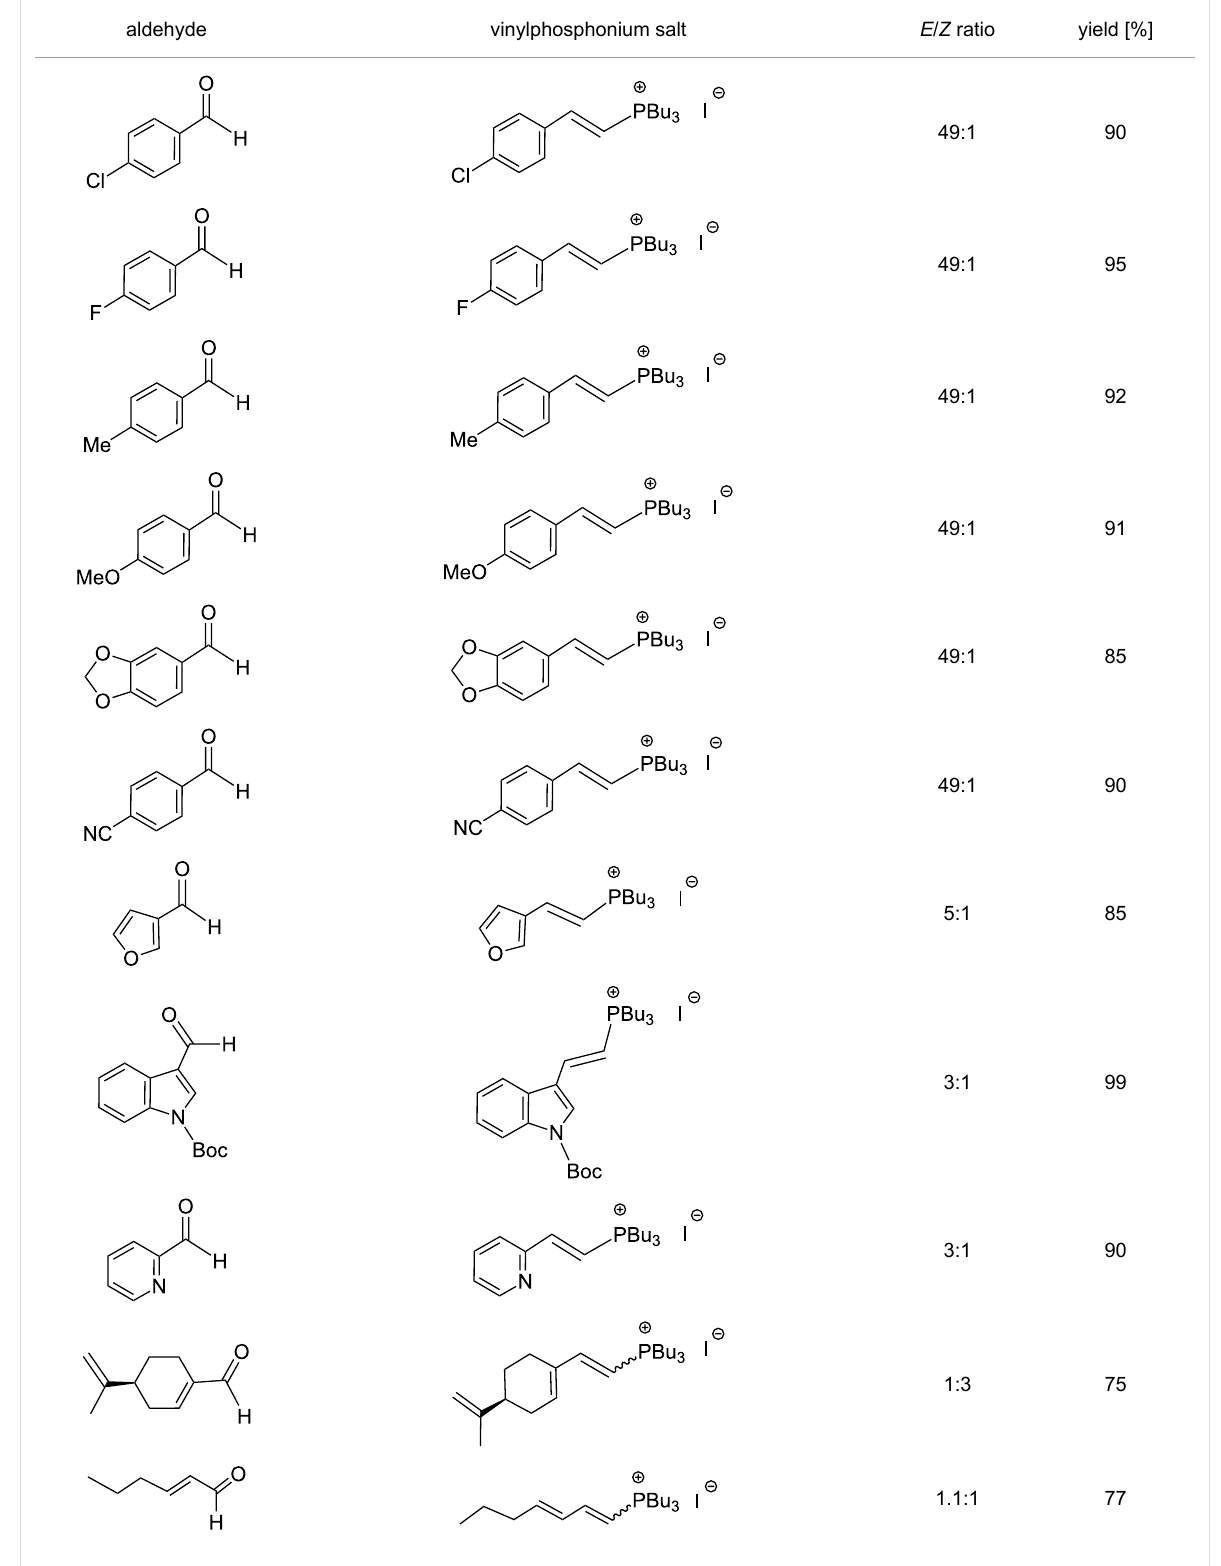
Table 1: Synthesis of vinylphosphonium salts by reaction of α -silyl ylides with aldehydes [17].